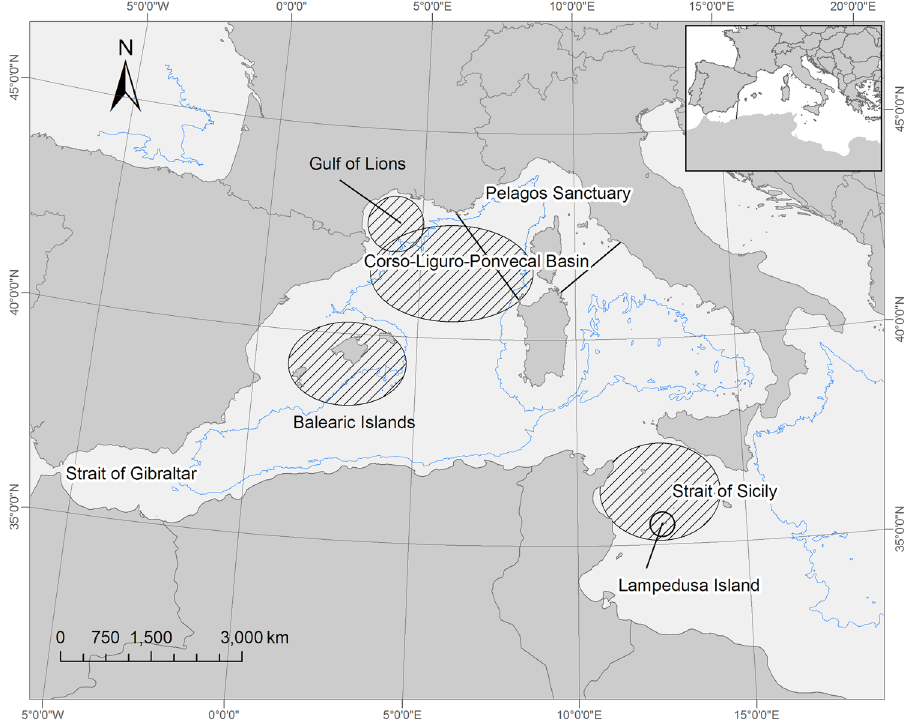
Figure 1. The two study areas selected for the research project: the Pelagos Sanctuary and the Strait of Sicily. The map was produced with ArcGIS Desktop 9.3